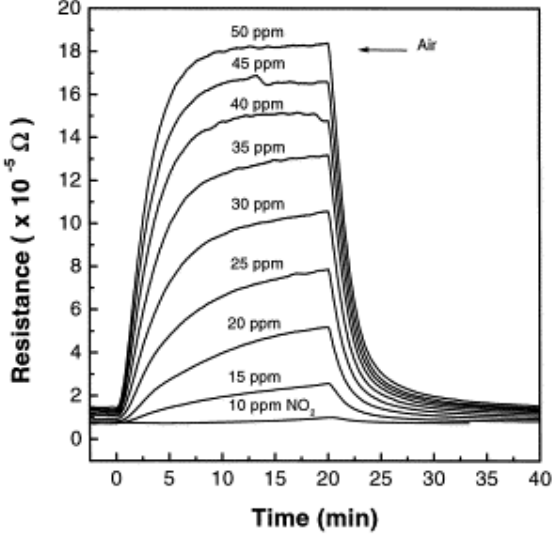
Figure 2. Electrical response of sprayed SnO working temperature . (Reprinted from reference [139] with permission from